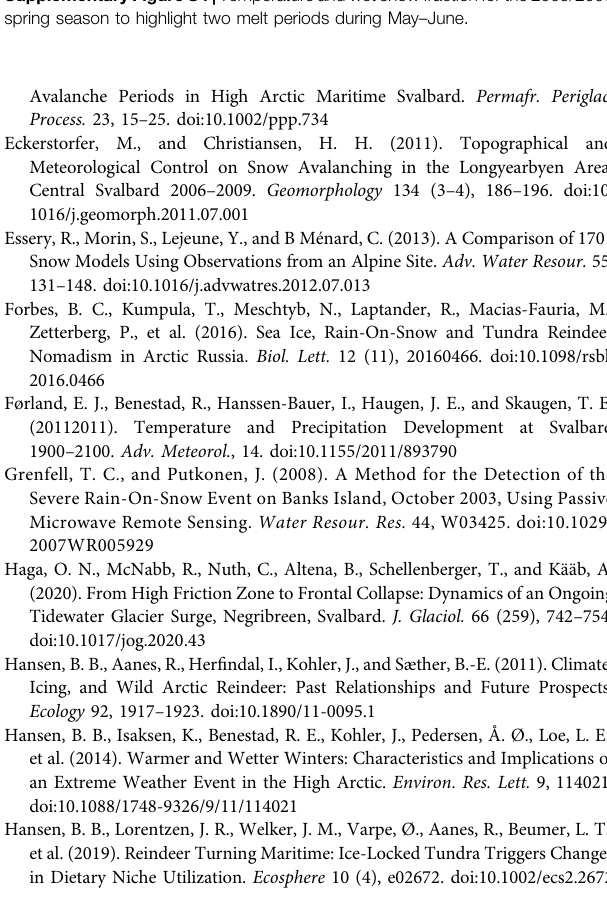
Supplementary Figure S1 | Number of days with data coverage per pixel for the study period, 2004 – 2021. Supplementary Figure S2 | Time series of melt onset anomalies mapped for the Svalbard archipelago in the period 2004 – 2020. The melt anomalies are calculated from the difference between the melt onset per pixel for individual years and the mean date of melt onset ( Figure 7 ). Supplementary Figure S3 | Time series of wintertime ROS events mapped for the Svalbard archipelago in the period from 2004 – 2020. SupplementaryFigureS4| Temperatureandwetsnowfractionforthe2005/2006 spring season to highlight two melt periods during May –